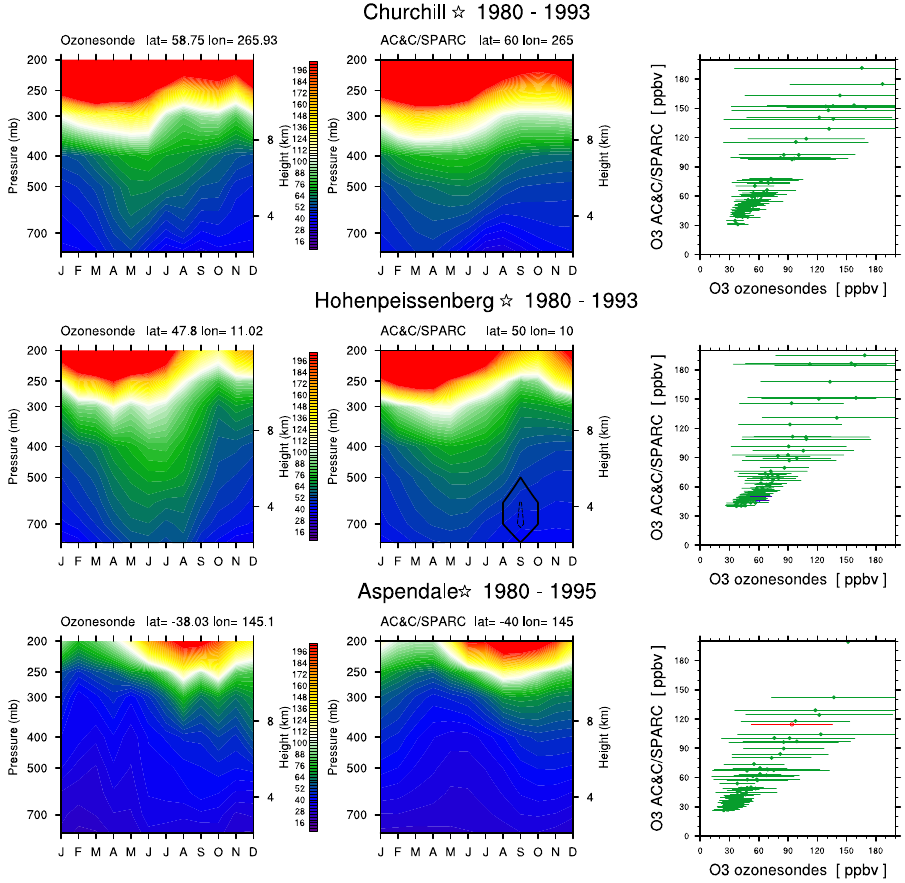
Fig. 11. Comparison of tropospheric ozone (ppb) from the AC&C/SPARC ozone database with ozonesonde observations at three different sites. The first column shows the annual cycle in observations from Logan et al. (1999), the second column is the equivalent plot from the AC&C/SPARC ozone database. The final column compares all points, with bars indicating the standard deviation in the observations. Where the model overpredicts (underpredicts) observations by more than one standard deviation, the point is plotted in red (purple); these points are shown in the second column by the solid (dashed)